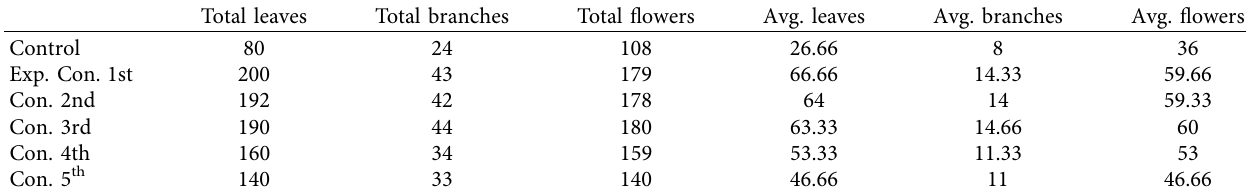
Table 5: Exomorphological parameters obtained during the 4th, 5th, and 6th